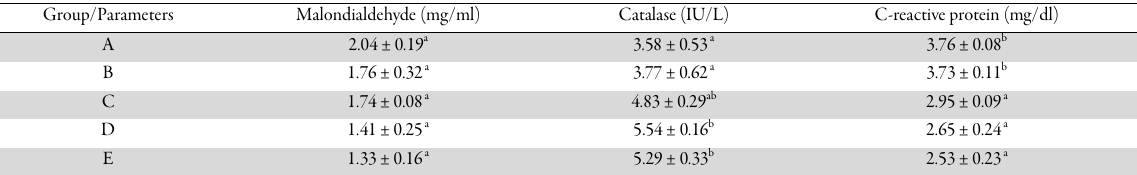
Table 2. Effect of sodium propanoate on some oxidative stress parameters of Clarias gariepinus (African cat fish) Group/Parameters